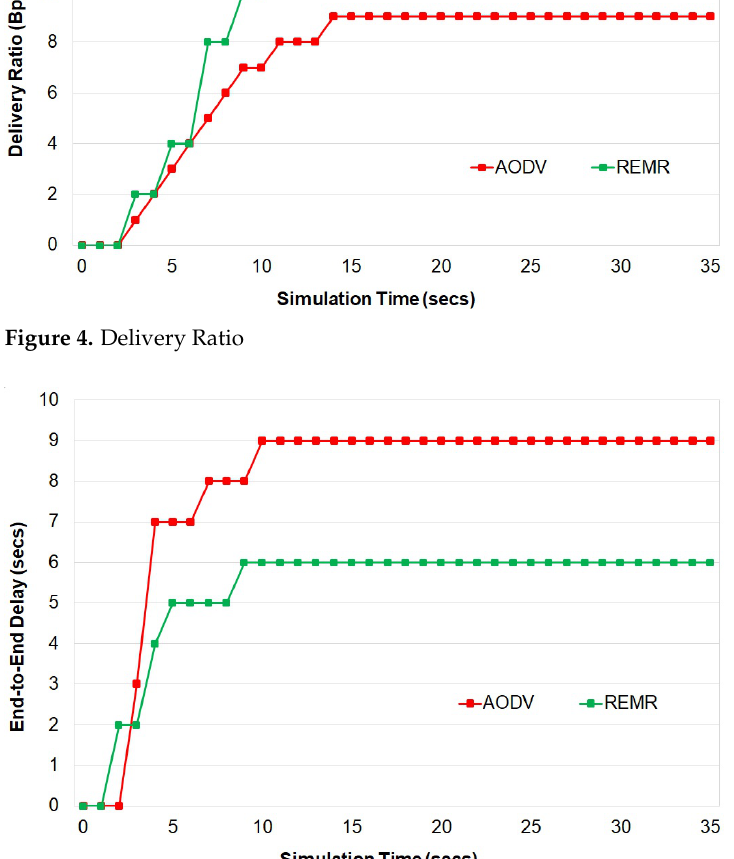
Figure 5. End-to-end